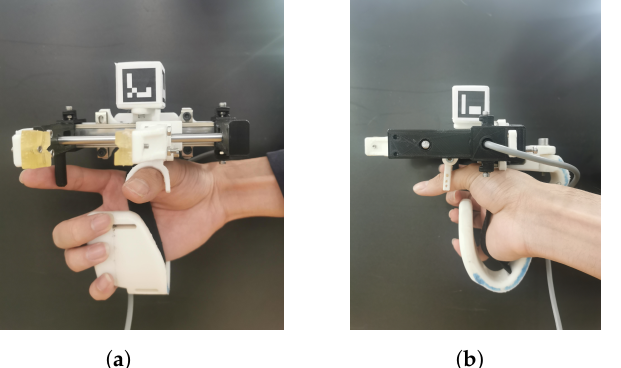
Figure 1. The exoskeleton for the grasping demonstration. ( a ) Front view of the exoskeleton. ( b ) Left view of the